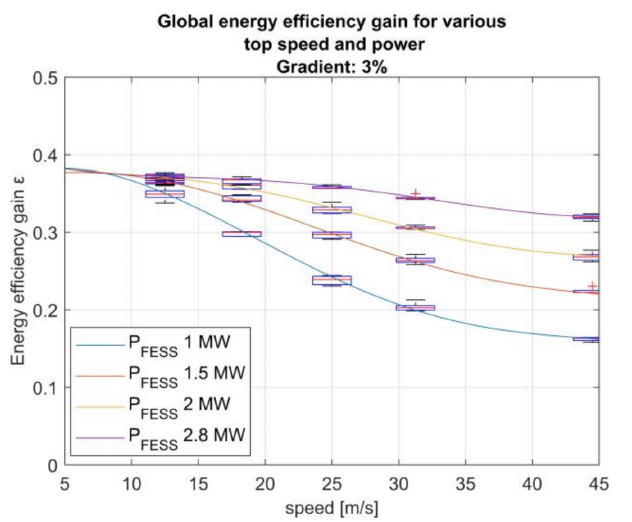
Figure 11. Three percent gradient efficiency gain for multiple top speeds and FESS